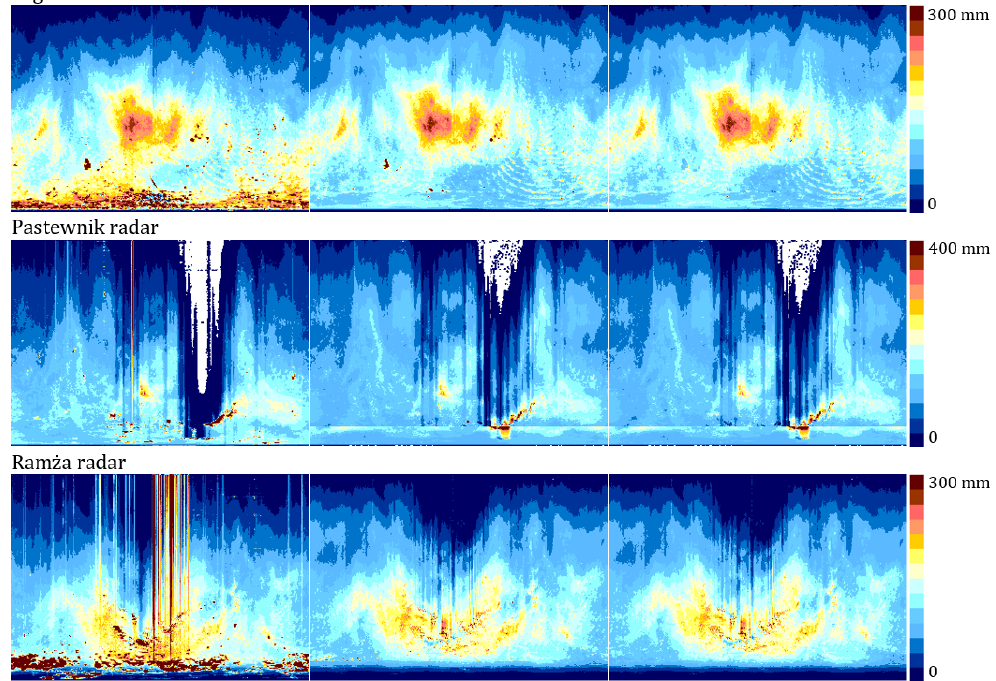
Figure 9. Comparison of the monthly sums of radar precipitation from (from the left): raw data, data after processing by the RADVOL- QC system without the TURBINE algorithm, and with the TURBINE algorithm (i.e. the complete RADVOL-QC system). Legionowo, Pastewnik, and Ram˙za radars; the lowest elevations. October